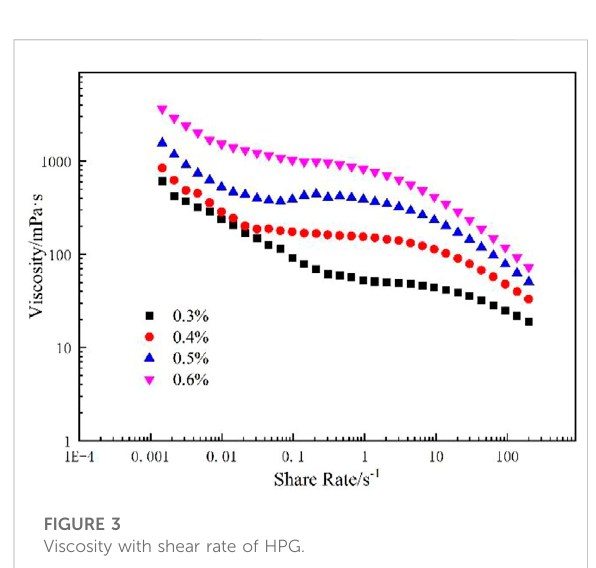
FIGURE 3 Viscosity with shear rate of